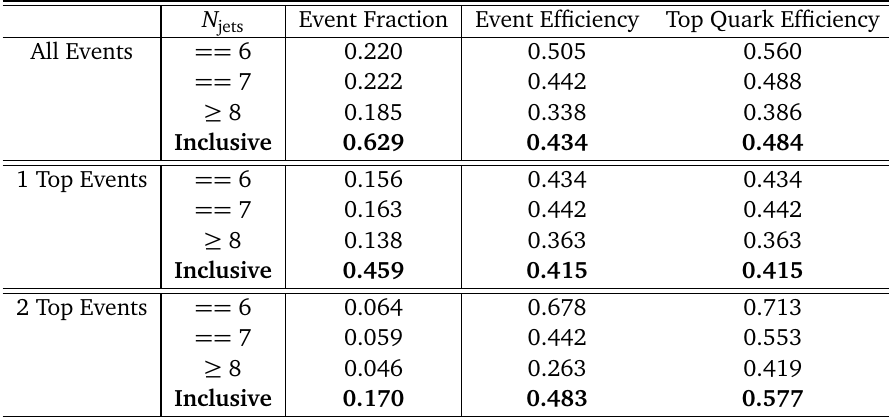
Table 9: χ 2 method results on t ¯ t using Herwig